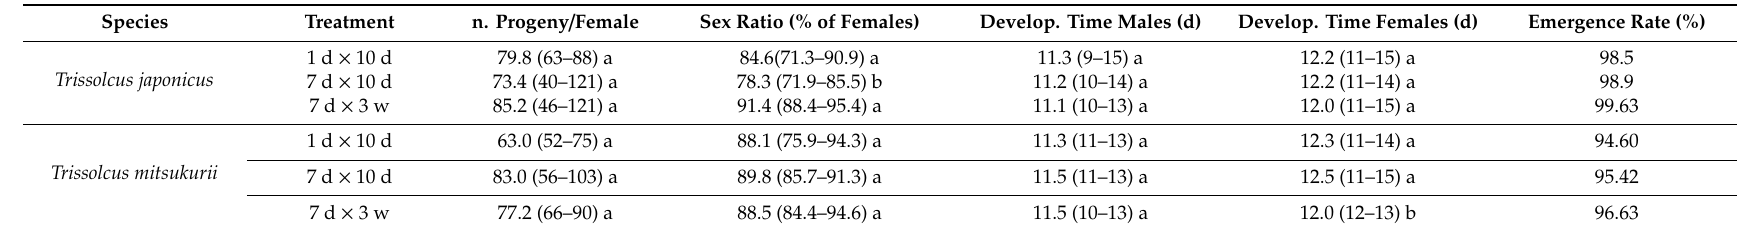
Table 1. Trissolcus japonicus and Trissolcus mitsukurii : number of progeny produced, sex ratio and development time using Halyomorpha halys eggs as host and under the following test conditions: 1 d × 10 d = 1-day-old females o ff ered new host egg masses daily for 10 consecutive days; 7 d × 10 d = 7-day-old females (host deprived until day 7) o ff ered new host egg masses daily for 10 consecutive days; 7 d × 3 w = 7-day-old females (host deprived) o ff ered host egg masses once a week for three consecutive weeks. Values followed by di ff erent letters within columns are significantly di ff erent ( p < 0.05); brackets indicate min. and max. range. Significant di ff erences among the three treatments were assessed separately for each